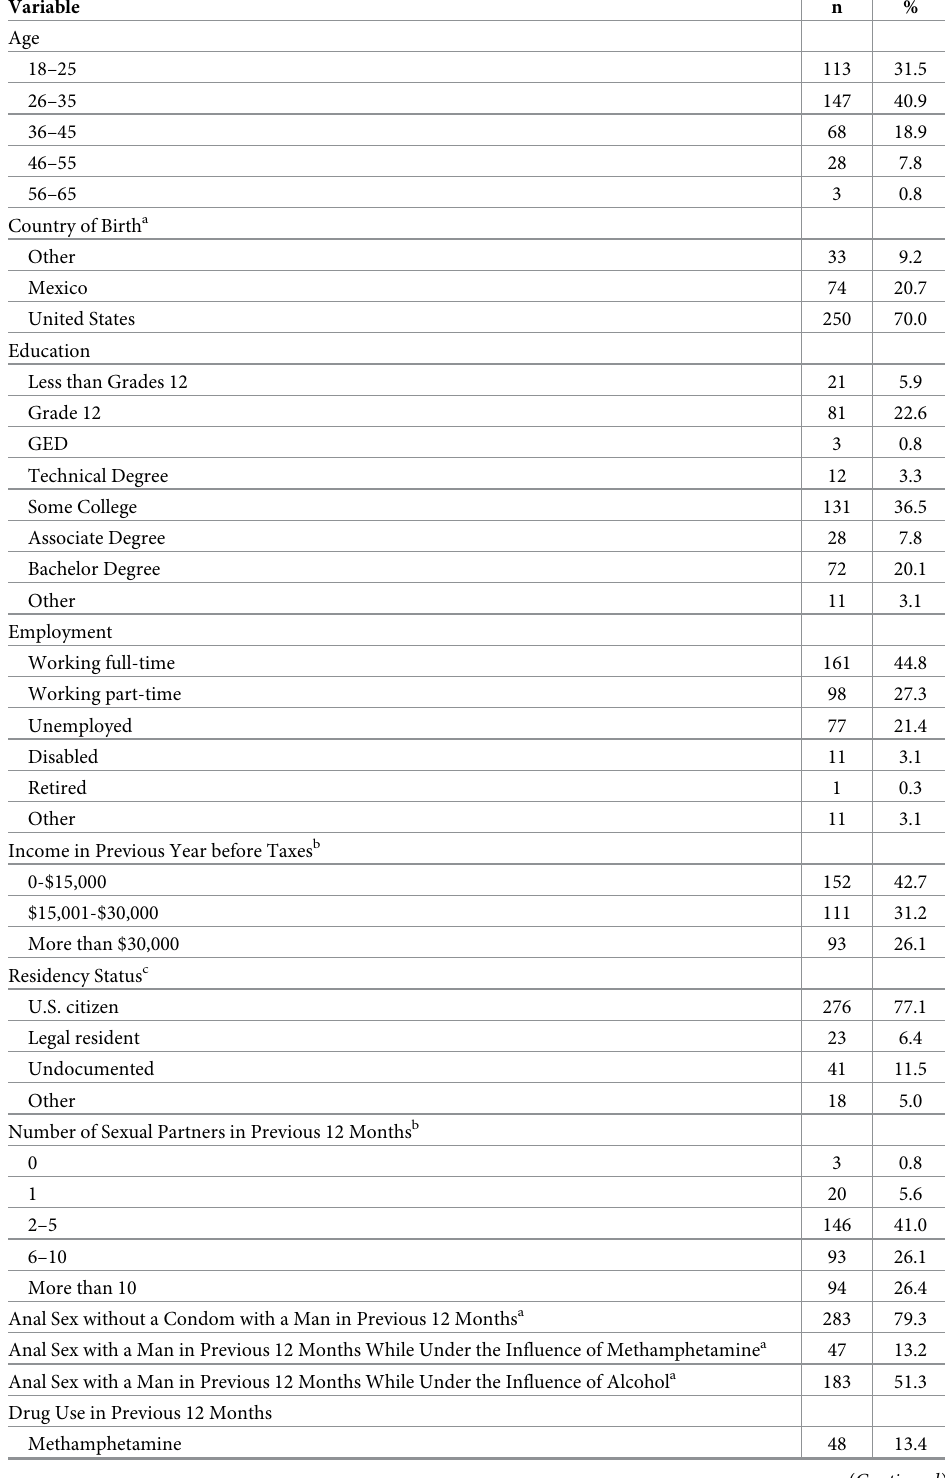
Table 1. Demographics, sexual behavior and alcohol/drug use among Proyecto Protégete participants (N =